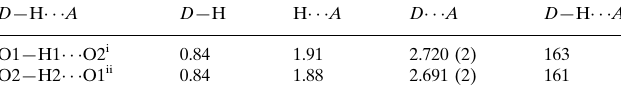
Hydrogen-bond geometry (A˚ , (cid:2)